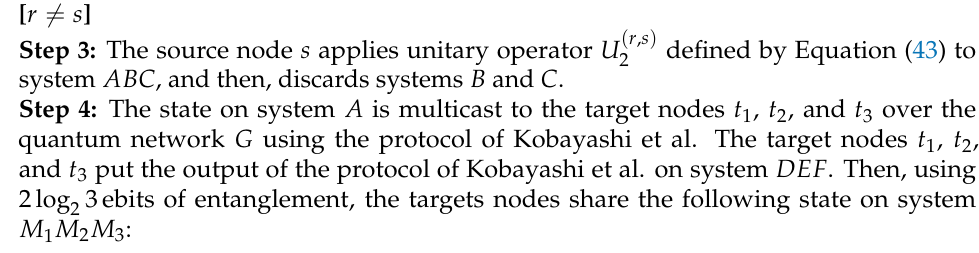
Protocol 4 Continuation of Protocol 3 for 1 → 3 quantum multicast network coding